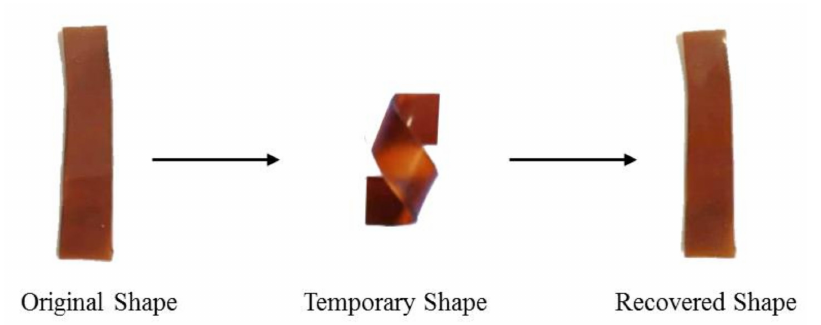
Figure 9. A demonstration of the shape memory recovery behaviors of EJO/MHPA polymers reported in this